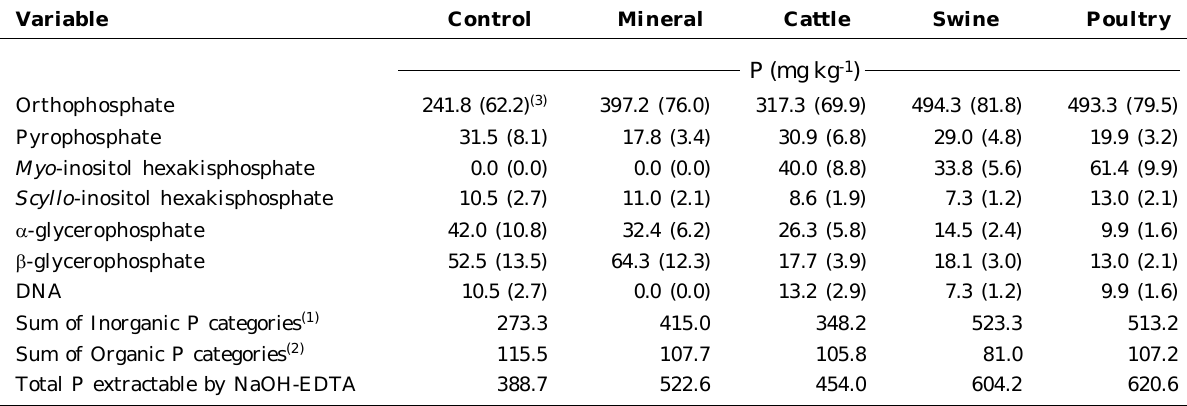
Table 3. Total extractable P by NaOH + EDTA and P concentration in each category identified by 31 P-NMR in extracts from soil under no tillage after application of mineral fertilizer and different kinds of organic fertilizer for nine years